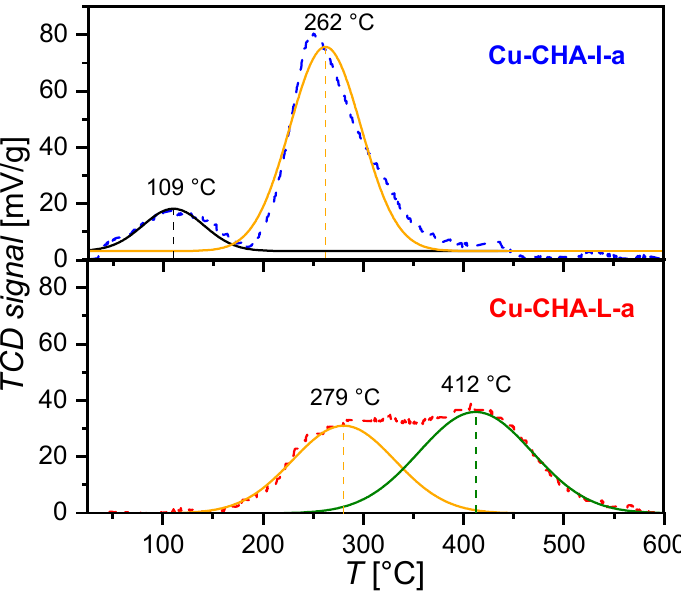
Figure 6. Deconvoluted H 2 -TPR profiles of Cu-CHA-I-a ( top ) and Cu CHA-L-a ( bottom ). To investigate the change in Al local environment in the zeolite framework induced by hydrothermal aging, solid-state 27 Al and 29 Si magic angle spinning NMR spectroscopy were conducted for the as-synthesized and aged Cu-chabazites. As shown in Figure 7a, both Cu-CHA-I and Cu-CHA-L showed a primary peak—“*”—at chemical shift 58 ppm and a low intensity peak—”ˆ”—at 0 ppm, which were attributed to tetrahedral Al incorporated into the framework and extra-framework octahedral Al, respectively [31]. The intensity